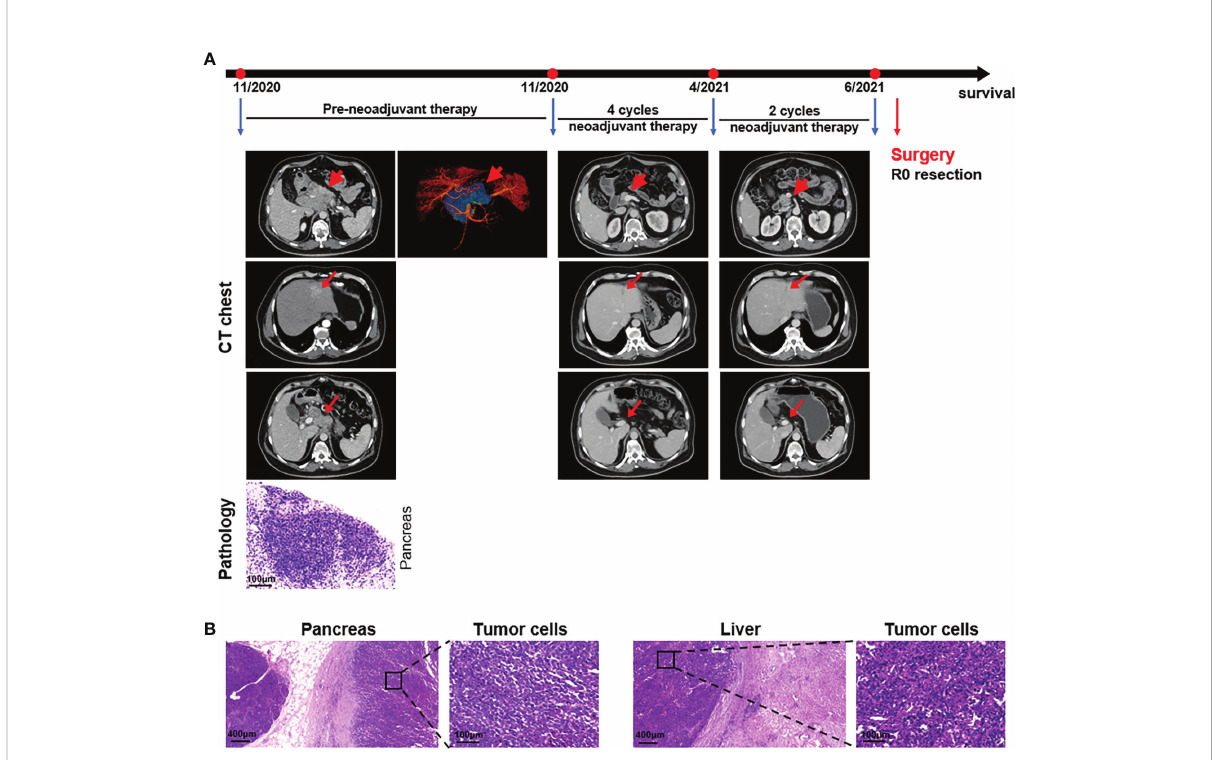
FIGURE 1 Case presentation of patient 1. (A) Timeline of disease status. Tumor responses shown by ECT of pre- and post-neoadjuvant therapy and pathological diagnosis of the pancreas with fi ne needle aspiration. (B) H&E staining of the isolated pancreas and liver tissues after